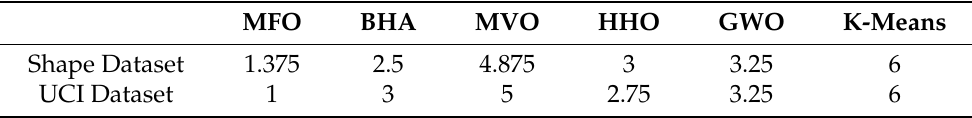
Table 5. Average ranking of MFO, BHA, MVO, HHO, GWO, k-means algorithms based on mean of objective values.